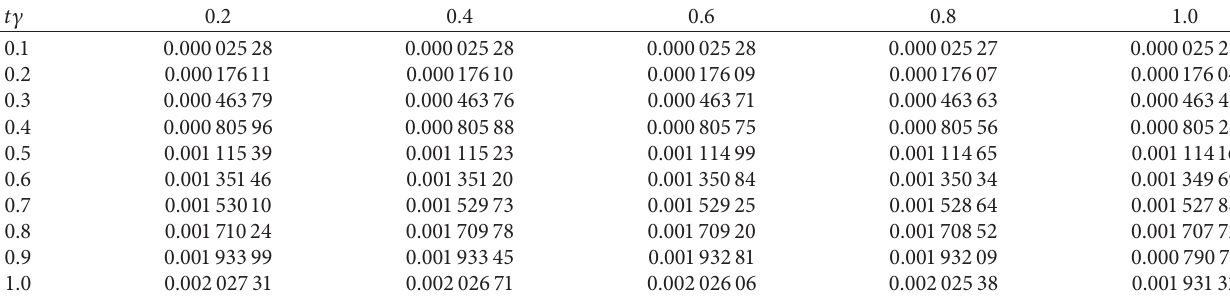
Table 5: Some values of w ( t, x ) for different values of c for P � 1 (for a polybutadiene beam).